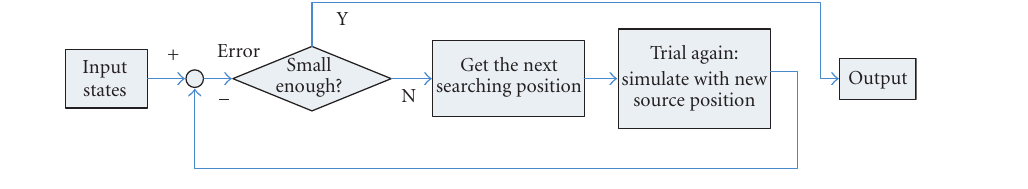
Figure 5: Algorithmic structure used for reconstruction.